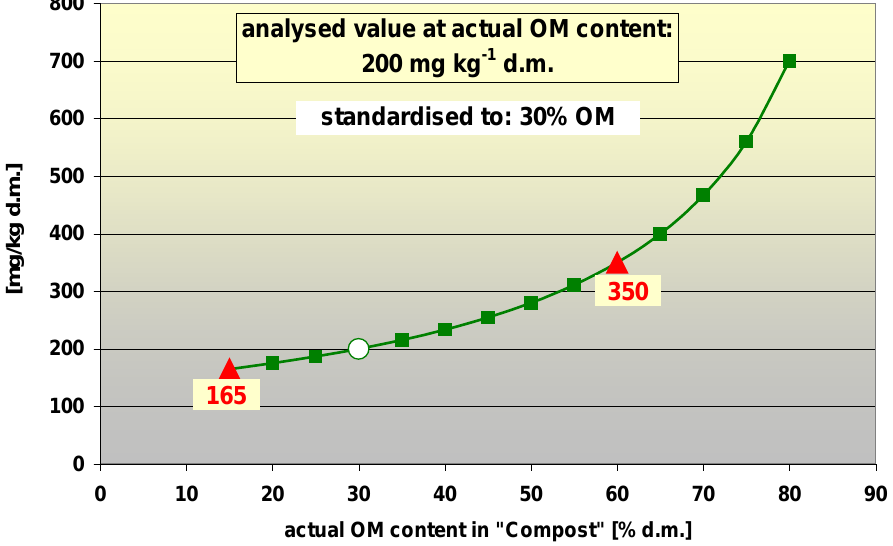
Figure 4: Example for the mathematical increase or decrease of metal concentration related to a standard organic matter content (30 % OM) with varying actual OM levels if the concentration in the original sample is analysed with 200 mg/kg d.m. Table 15 lists heavy metal limit values of statutory and voluntary standards in EU Member States